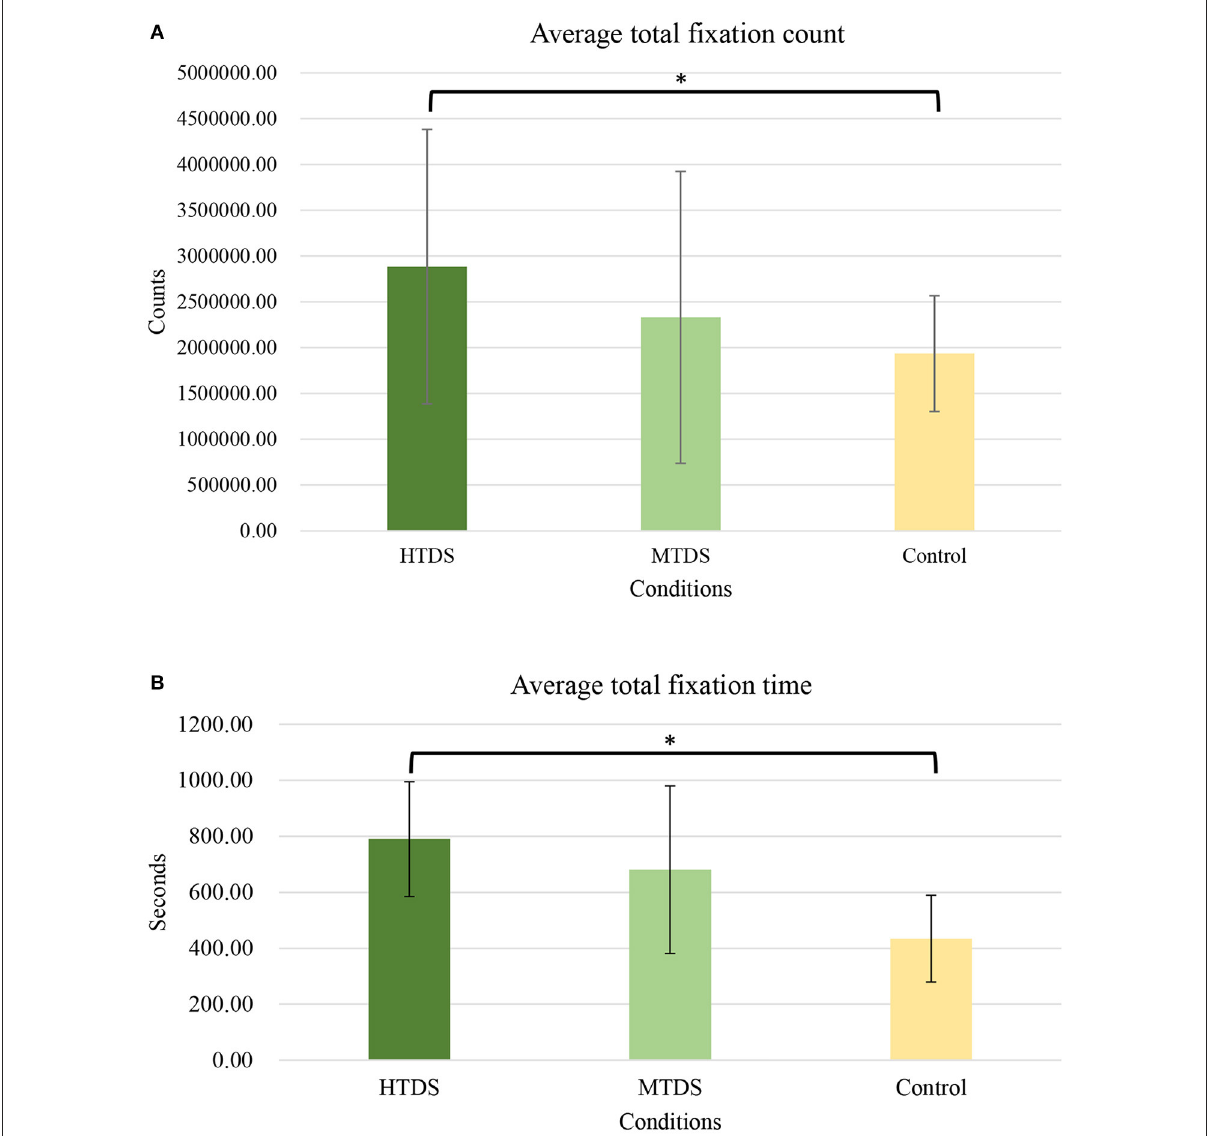
FIGURE6 (A) Average total fixation count for the high tree density sportscape (HTDS) and the medium tree density sportscape (MTDS) groups during exercise. (* p < 0.05). (B) Average total fixation time for the high tree density sportscape (HTDS) and the medium tree density sportscape (MTDS) groups during exercise. (* p <